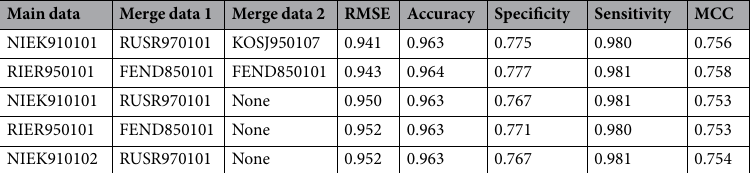
Table 2. Performances of seven prediction models.